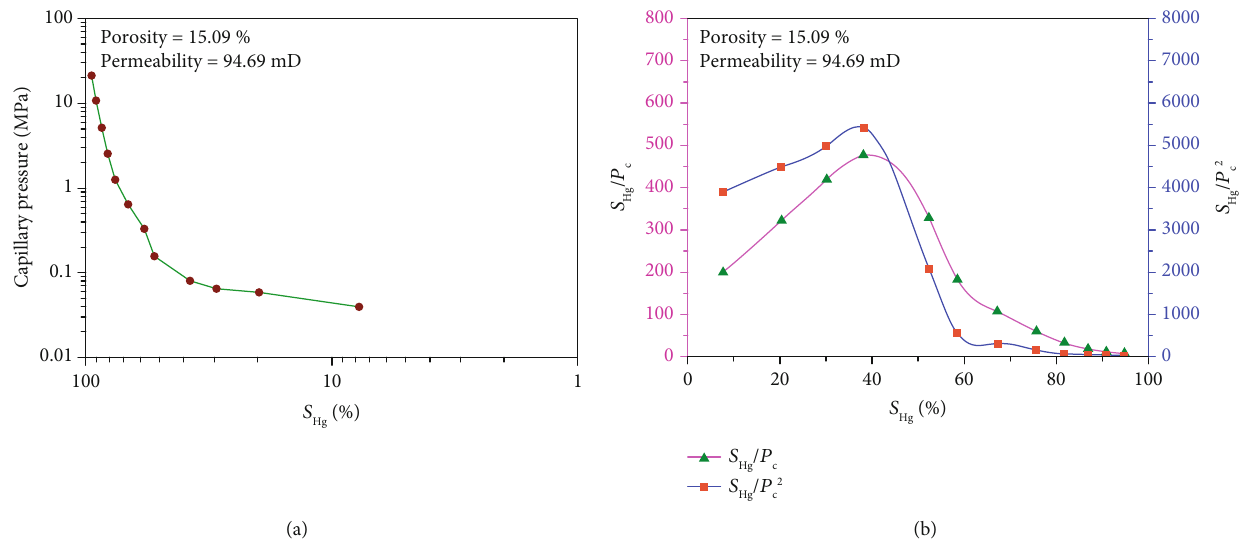
Figure 6: MICP curve (a) and related Swanson parameters and capillary parachor parameters (b) for one of the 22 core